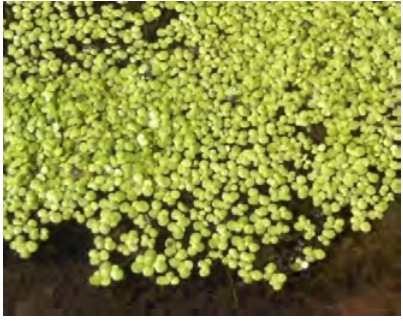
Figure 7. Lemna minor (floated local plant).